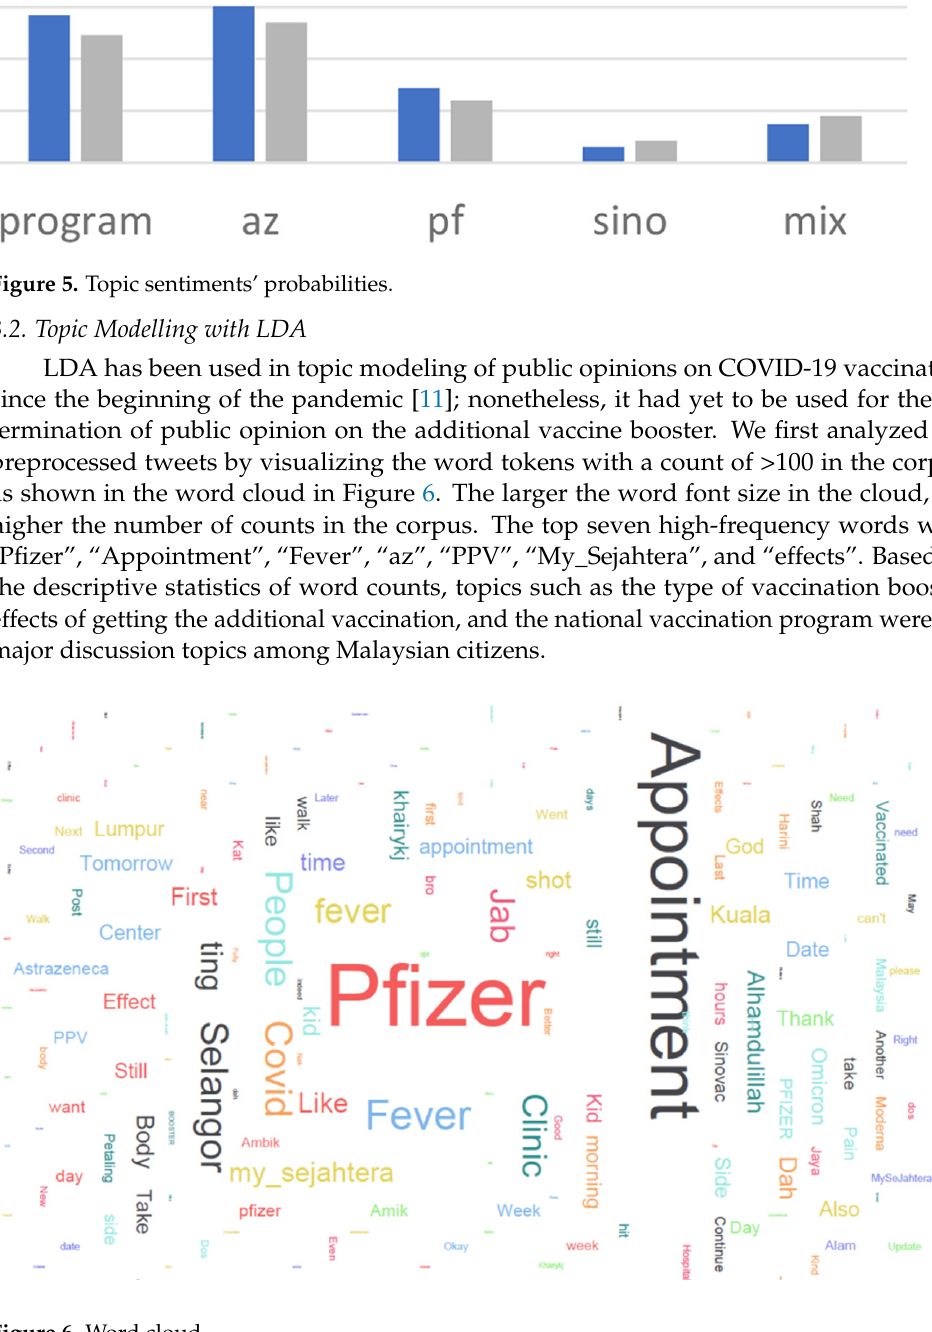
Figure 6. Word cloud. We used the LDA to discover the topics discussed by Malaysian Twitter users. For this study, three topics were pre-assigned based on the word cloud generated in Figure 6, and the results of the words’ allocation are summarized in Table 1.